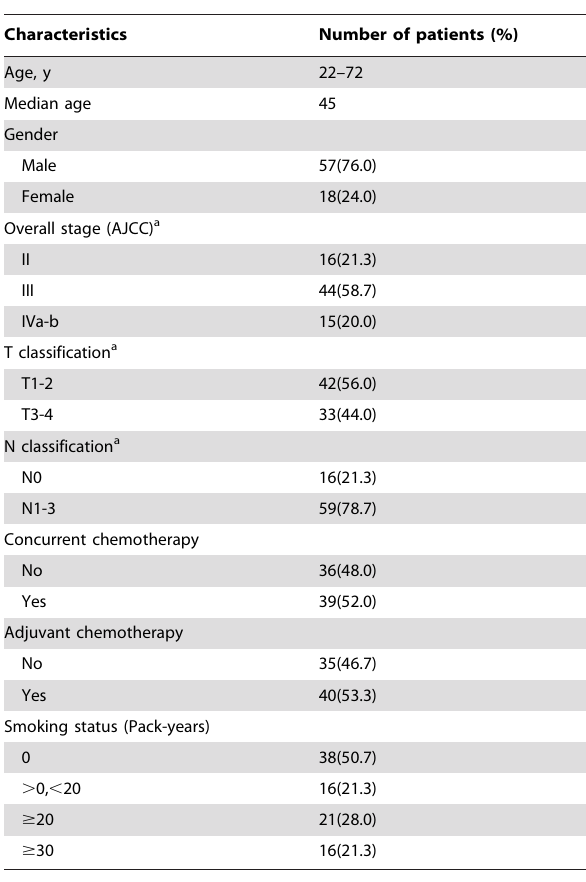
Table 1. Patient demographics and treatment